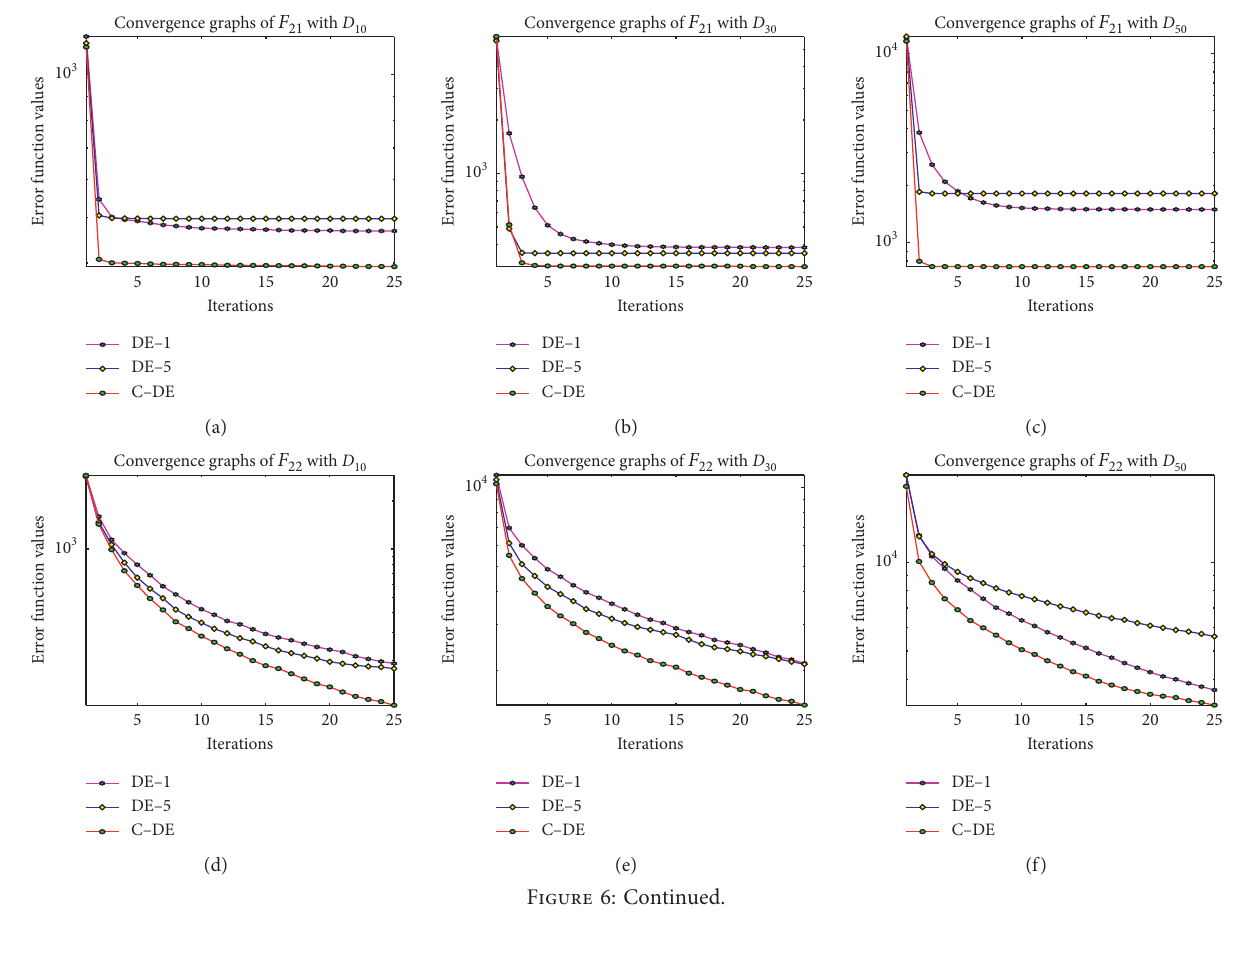
to F solved with DE-1, DE-5, and C-DE in n � 10, 30, and 50 16 20